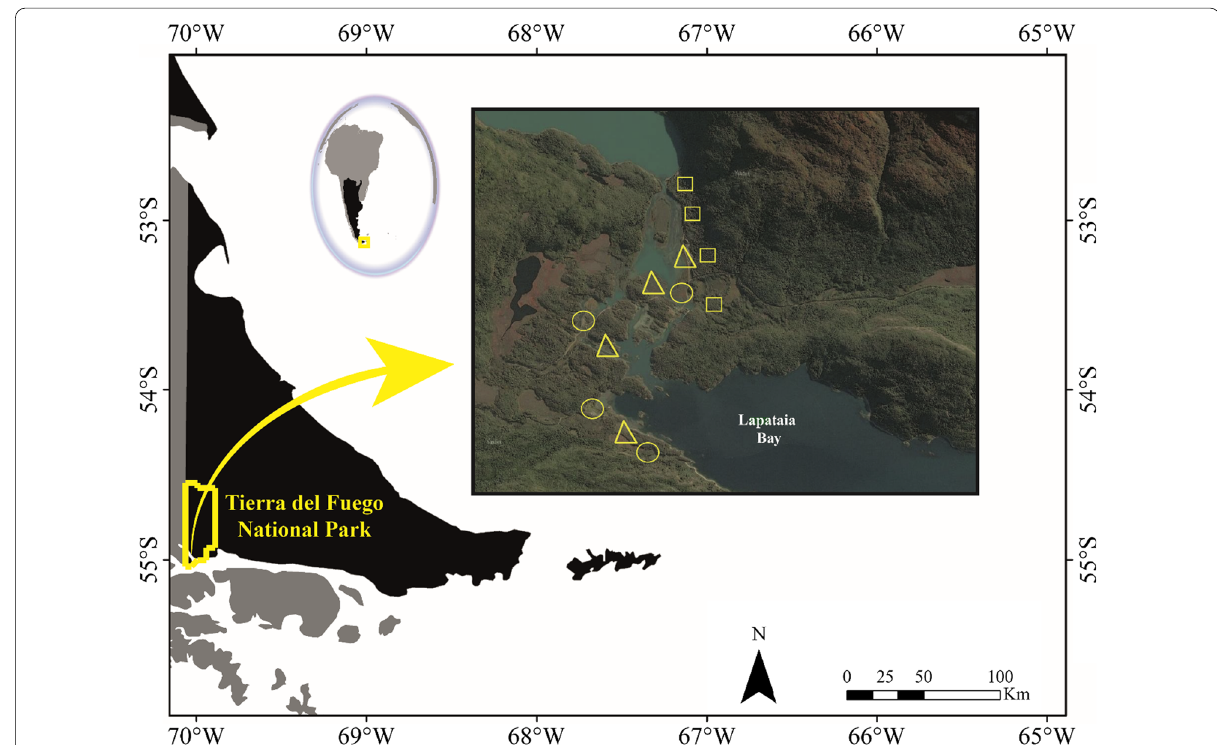
Fig. 1 Location of the study site and plots at the different vegetation types within the Tierra del Fuego National Park. Nothofagus forests shrublands triangles, grasslands = =